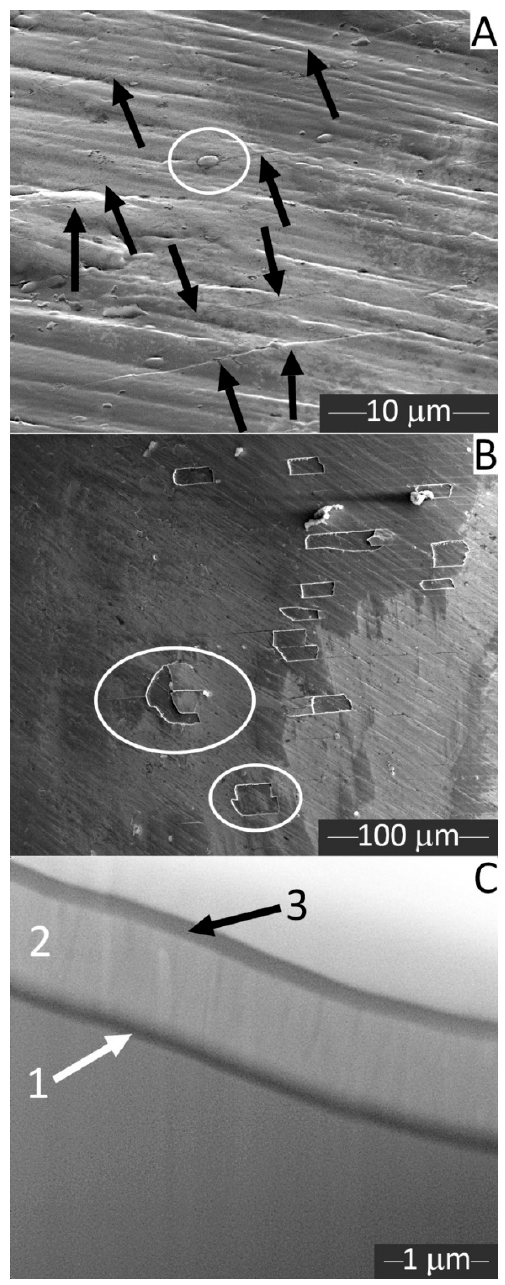
Figure 4. Secondary electron SEM micrographs: detail ( A ) and overview ( B ) of the surface of a Procodile file, imaged under a tilt angle of 52° (arrows: microcracks, circle in panel A = cluster; circles in panel B = delaminations), and cross-section of the Procodile file ( C ) obtained by in situ FIB machining (numbers indicate the distinct layers composing the surface coating of the Procodile file).